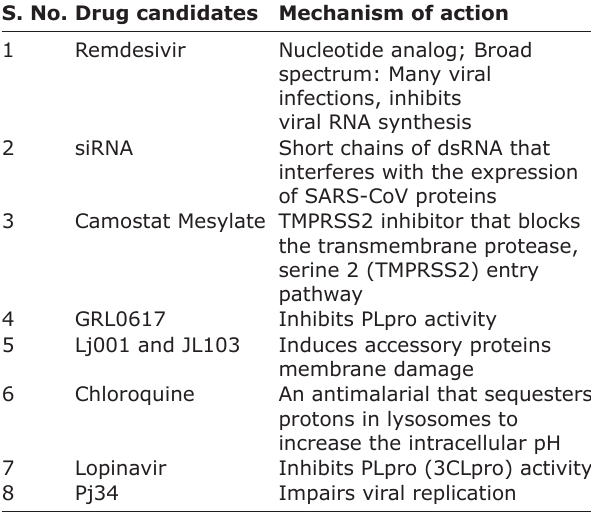
2710Available Table-1: Some potential drug candidates acting against the SARS-CoV-2 [72] S. No. Drug candidates Mechanism of action 1 Remdesivir Nucleotide analog; Broad spectrum: Many viral infections, inhibits viral RNA synthesis siRNA Short chains of dsRNA that interferes with the expression of SARS-CoV Veterinary World, EISSN: 2231-0916